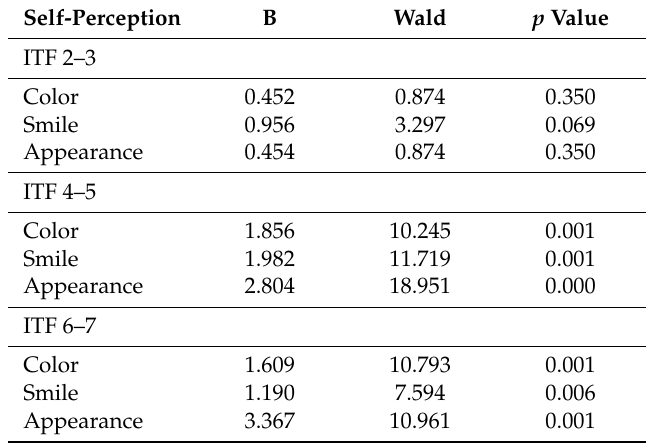
Table 4. Logistic regression model (concerns about color, smile and appearance) in the degrees of fluorosis